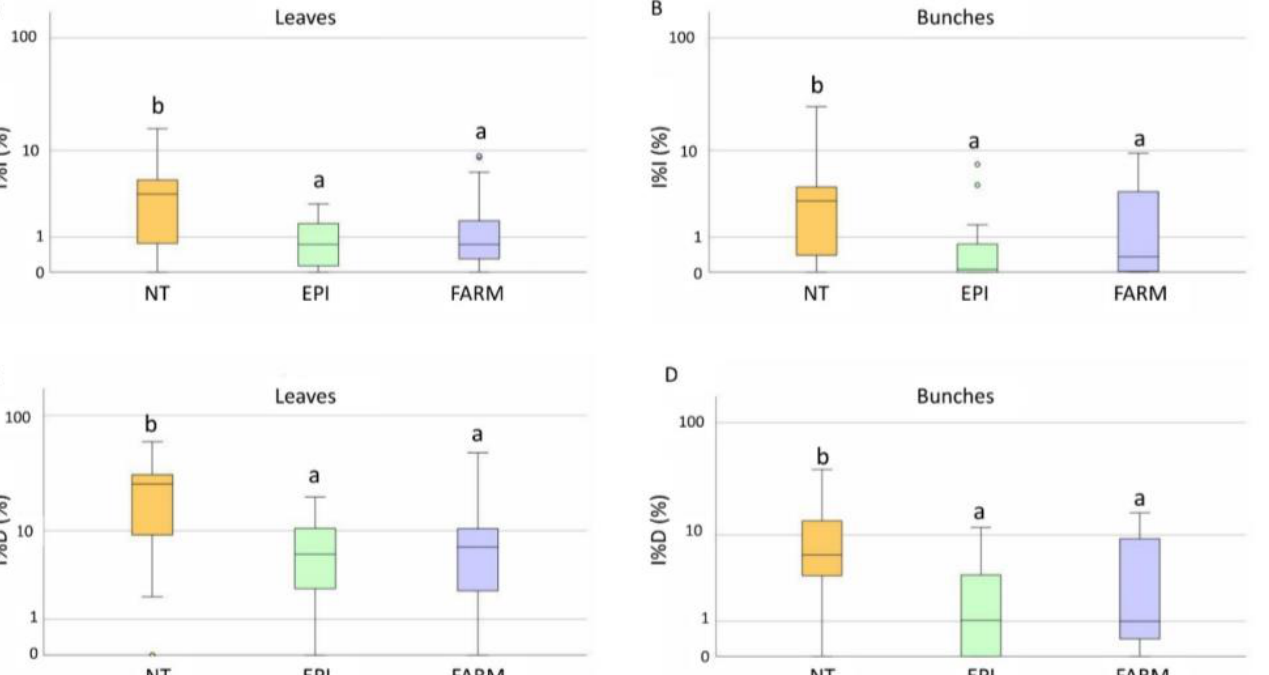
Table 4. Dates of spray applications and total number of treatments performed for powdery mildew control in EPI (E) and farmers’ (F) plots of the nine vineyards during 2 021. Different letters indicate significant differences among samples ( p < 0.05).